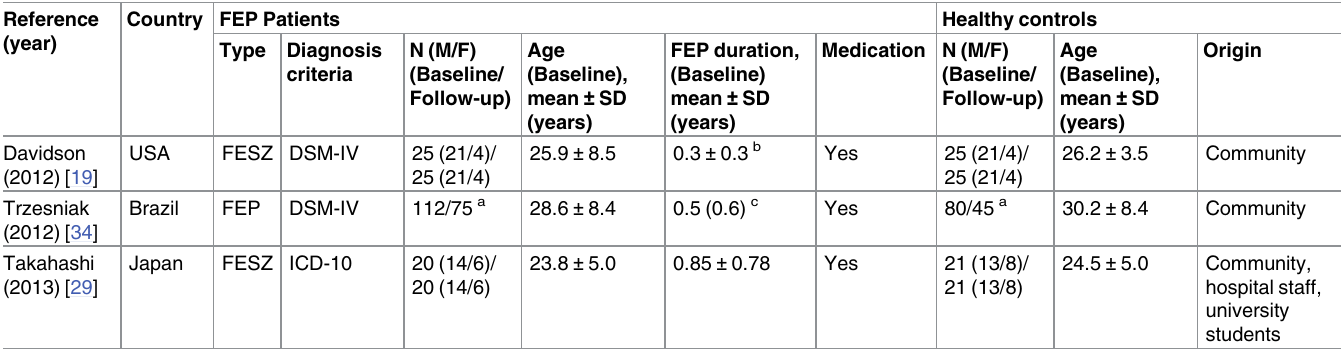
Table 3. Sample characteristics of longitudinal